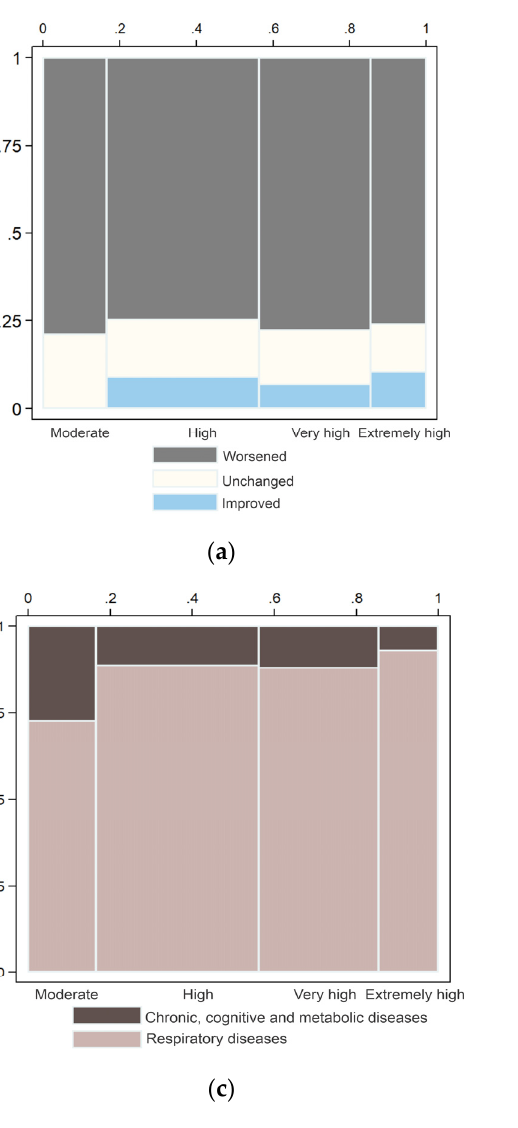
Figure 6. Responses to the perception of air quality by the estimated categories of exposure to PM 10 . ( a ) Fractions of the perceived changes in the air quality on time (last four years); ( b ) fractions of the perceived air quality at a local level; ( c ) fraction of the responses about the knowledge of health effects related to air pollution; and ( d ) fractions of the perceived primary sources of air pollution.